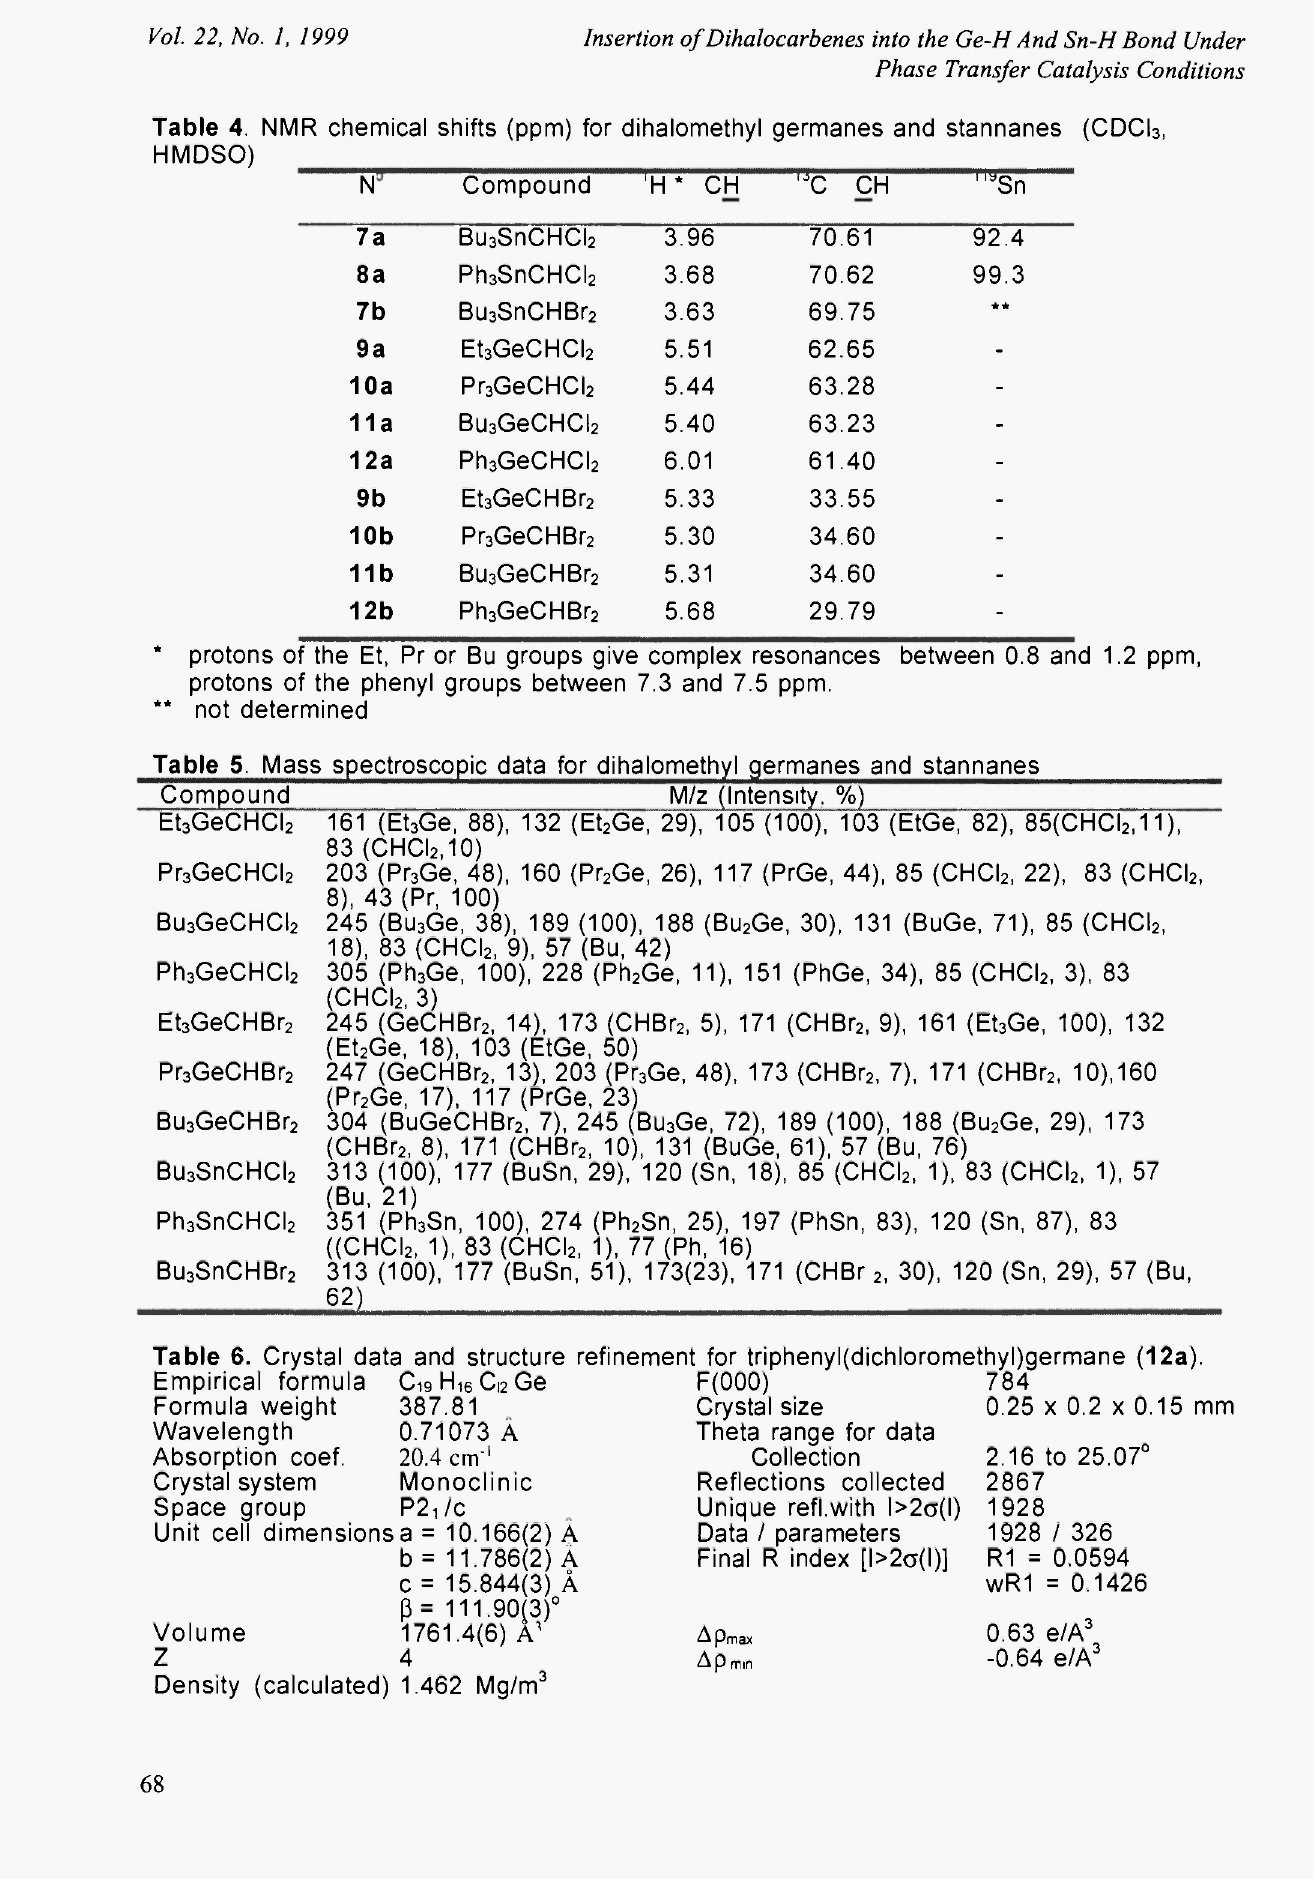
Table 4. NMR chemical shifts (ppm) for dihalomethyl germanes and stannanes